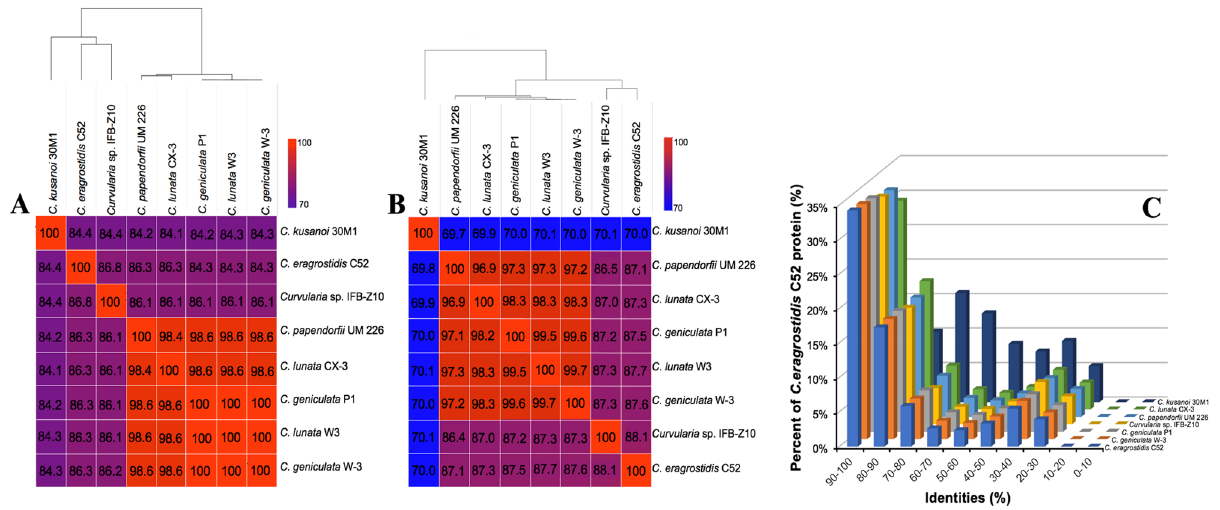
Figure 2. Phylogenomic calculation of the average nucleotide identity ( A ), average amino acid identity ( B ), and amino acid sequence identity ( C ) of C. eragrostidis C52 with available genomes within the genus